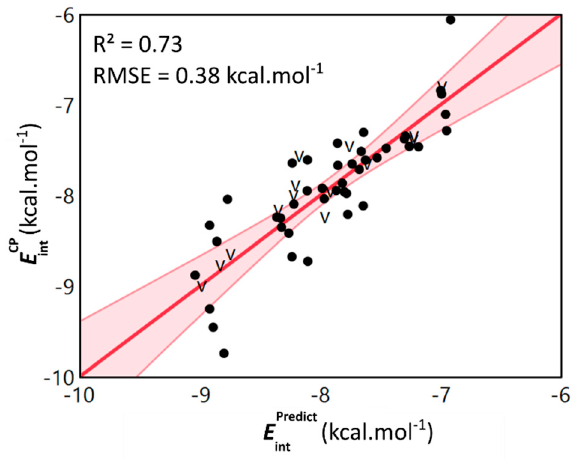
Figure 6. Scatterplot of the dimer level computed counterpoise-corrected interaction energies E CP int and the predicted interaction energies E Predict int obtained through the monomer level model. Both values are expressed in kcal · mol − 1 and validation data points are denoted by the letter v. The linear fit and associated confidence interval are shown in red and are accompanied by the R 2 -value and RMSE.